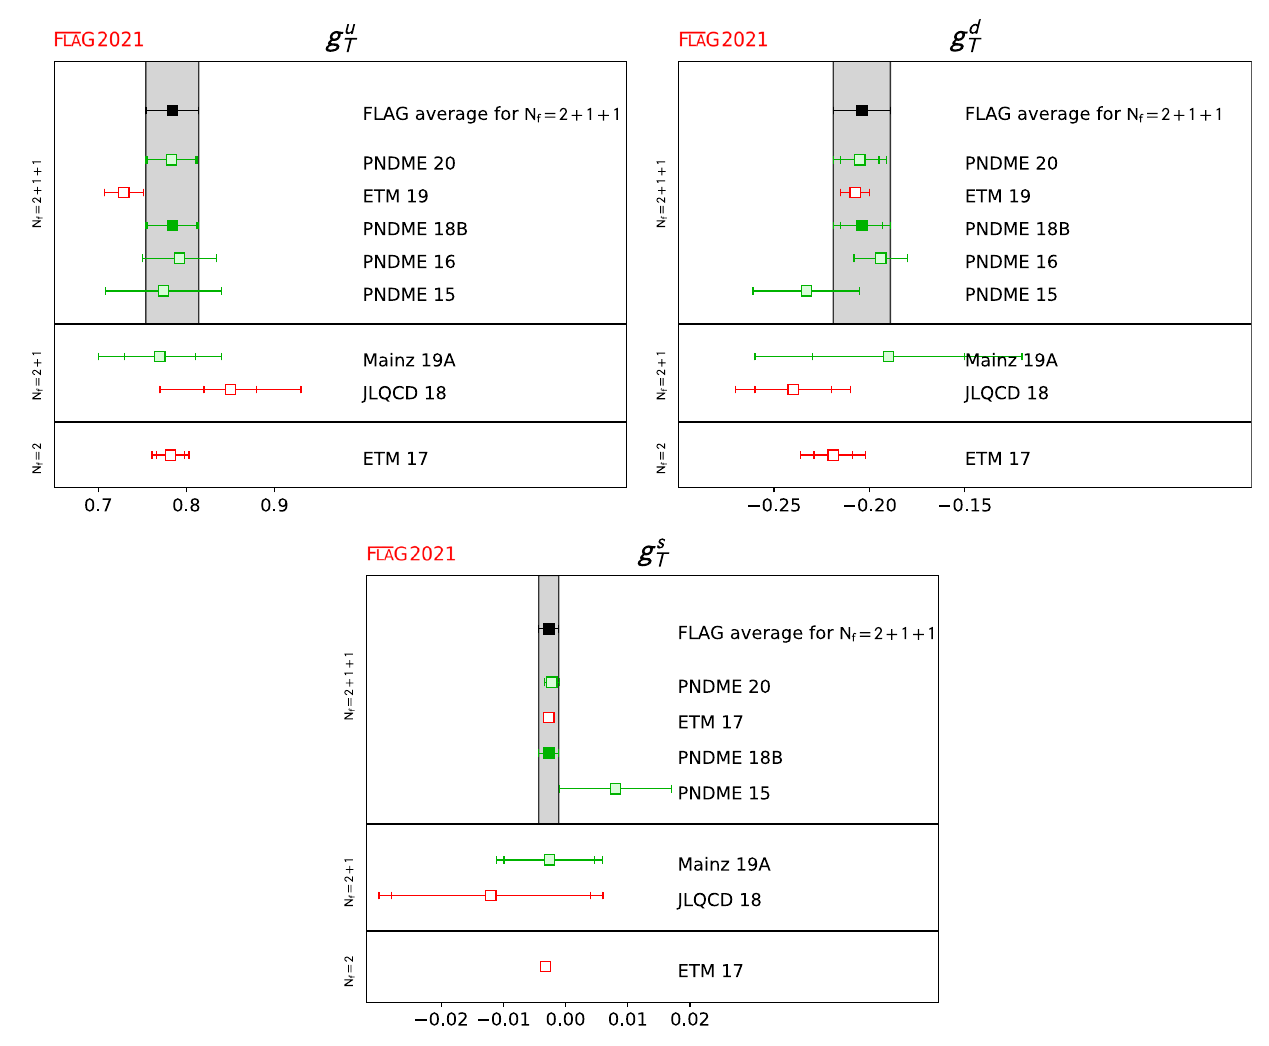
Fig. 49 Lattice results and FLAG averages for g u , d , s